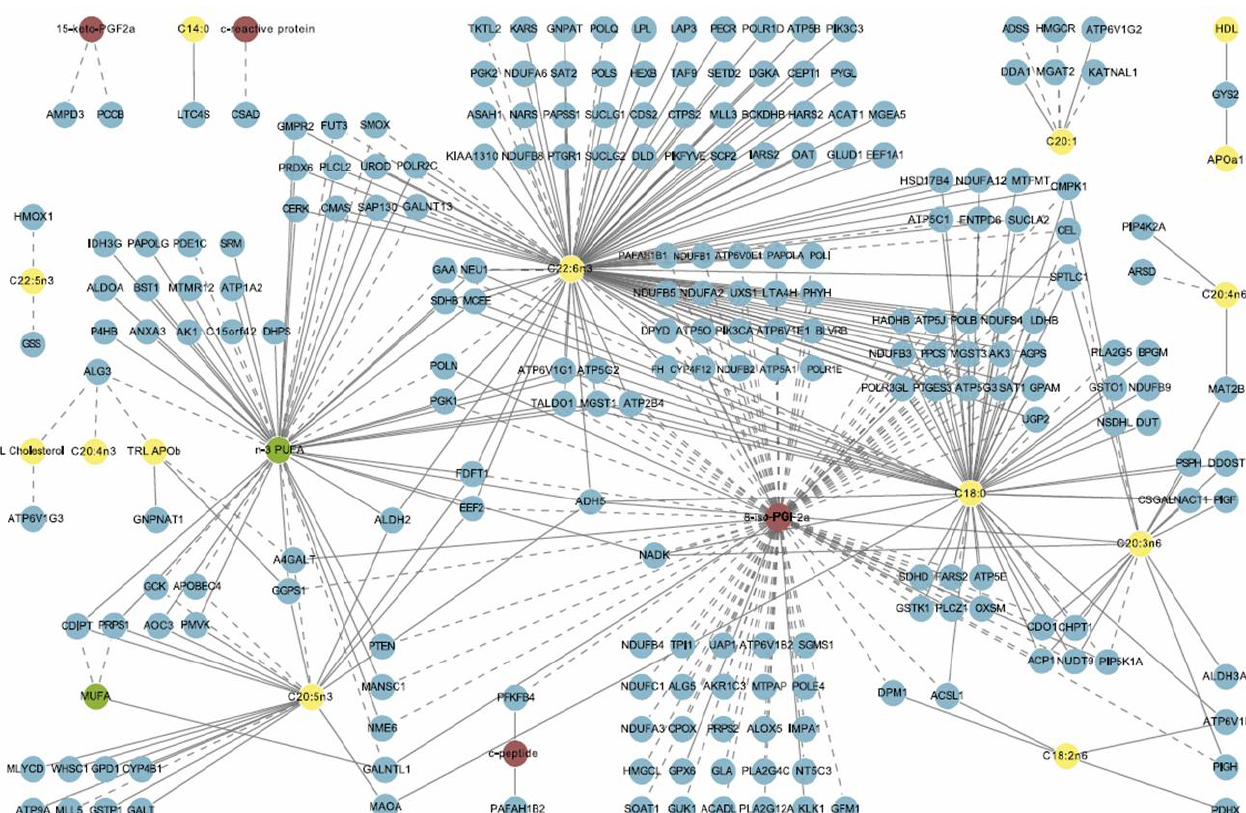
Figure 3. Network of associations between dietary intake, adipose gene expression, and phenotypic markers. Green nodes: nutrients; yellow: lipid, fatty acid, and apolipoprotein variables in blood; red: inflammatory and oxidative stress markers in blood; blue: gene expression (enzyme) in adipose tissue. Solid line: positive correlation/covariance; dashed line: negative correlation/covariance. Note: This figure is adapted with permission from [24], Copyright © 2011 Morine et al